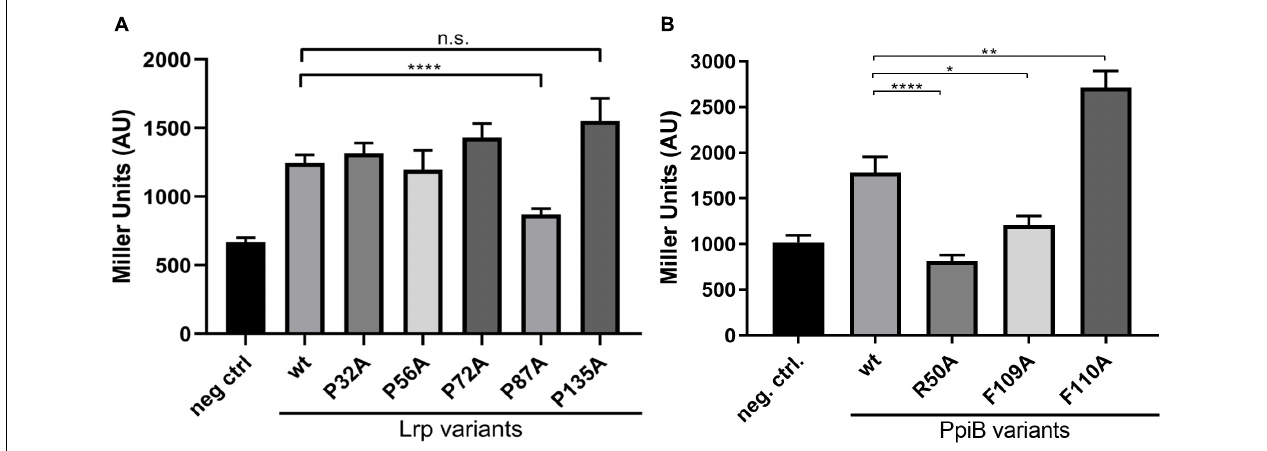
FIGURE 4 | CdPpiB targets P87 in CdLrp and this interaction depends on conserved amino acids. (A) β -galactosidase activities of E. coli BTH101 clones carrying combinations of wt CdPpiB and single proline exchange mutants of CdLrp. (B) β -galactosidase activities of E. coli BTH101 clones carrying combinations of wt CdLrp and single amino acid exchange mutants of CdPpiB. Clones carrying wt CdPpiB and the empty companion vector pKNT25 served as negative control in both experiments. Shown are mean and SEM of three independent experiments with at least five clones each. Statistical significance was calculated by unpaired t- Test with Welch’s correction ( ∗ p ≤ 0.05, ∗∗ p ≤ 0.01, ∗∗∗∗ p ≤ 0.0001, n.s., not